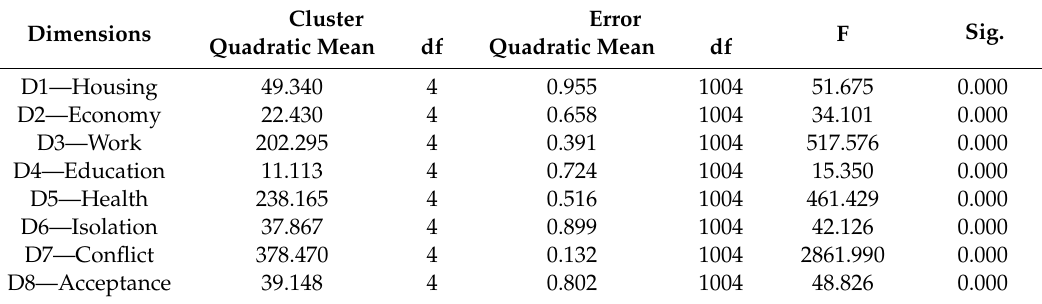
Table 2. Analysis of Variance (ANOVA).